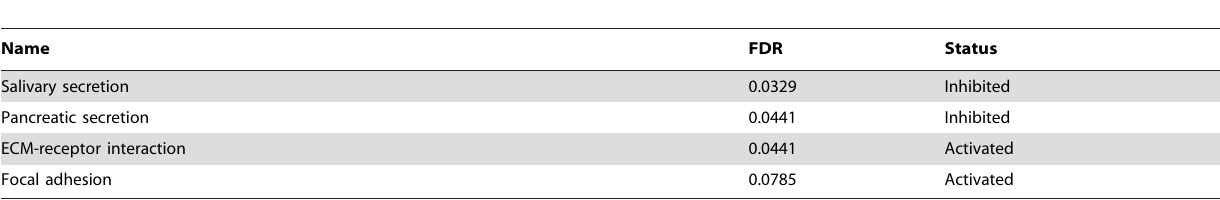
Table 3. SPIA results when provided with DE genes significant at 1%